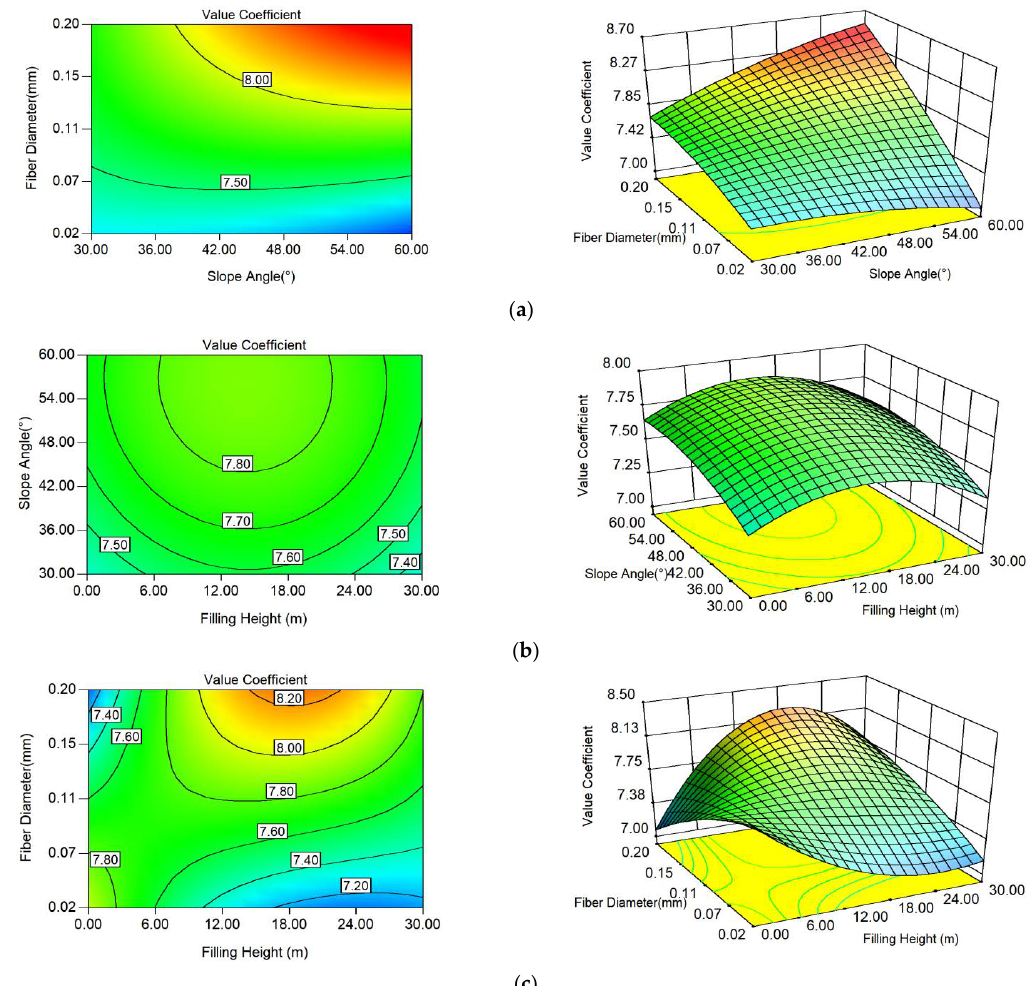
Figure 7. Response surface and contour plots. ( a ) Interaction between fiber diameter and slope angle. ( b ) Interaction between filling height and slope angle. ( c ) Interaction between filling height and fiber diameter.